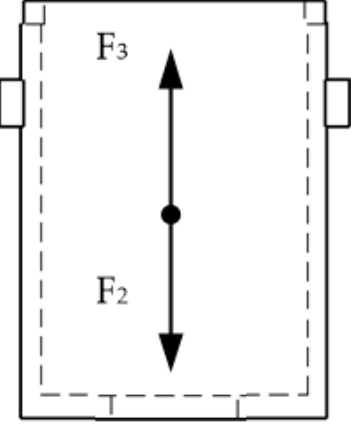
Figure 16. Force relationship of the inner sleeve.